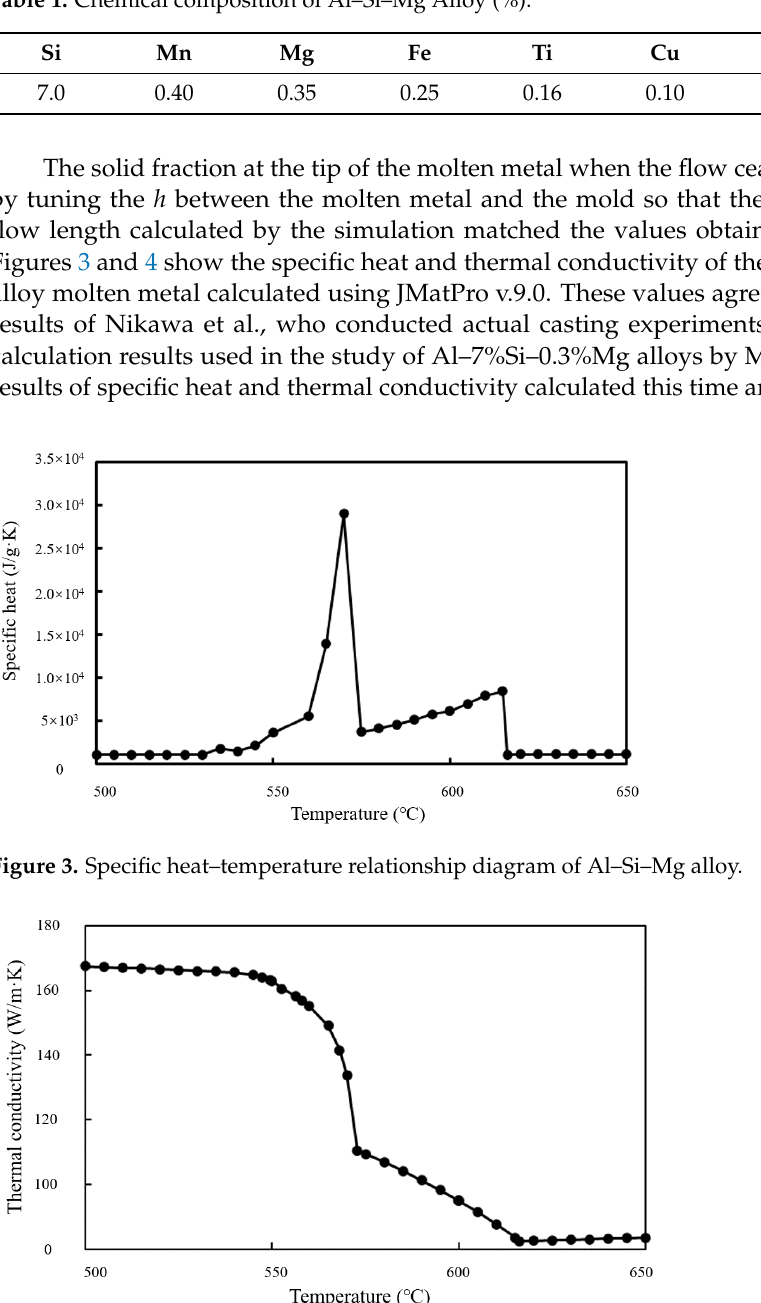
Table 1. Chemical composition of Al–Si–Mg Alloy (%).